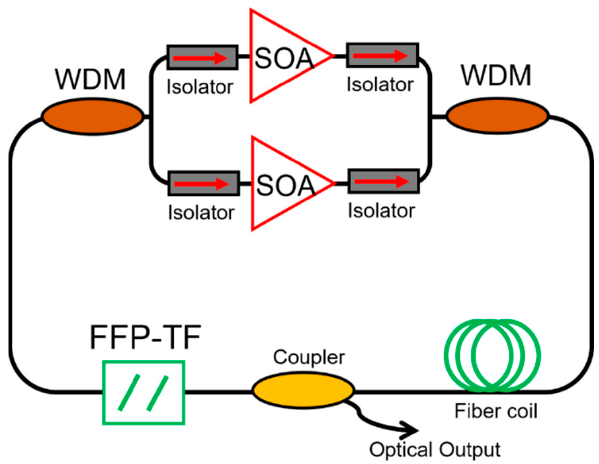
Figure 5. Schematic of a broadband FDML laser which consists of two SOAs of adjacent wavelength bands arranged in parallel. Isolators are used before and after each SOA to ensure unidirectional operation. The SOAs are then coupled through two WDMs to complete the ring-cavity. Other broadband components include an FFP-TF for wavelength tuning, a fiber coil to set the cavity resonance frequency and a fiber coupler for output coupling. Adapted with permission from Ref.